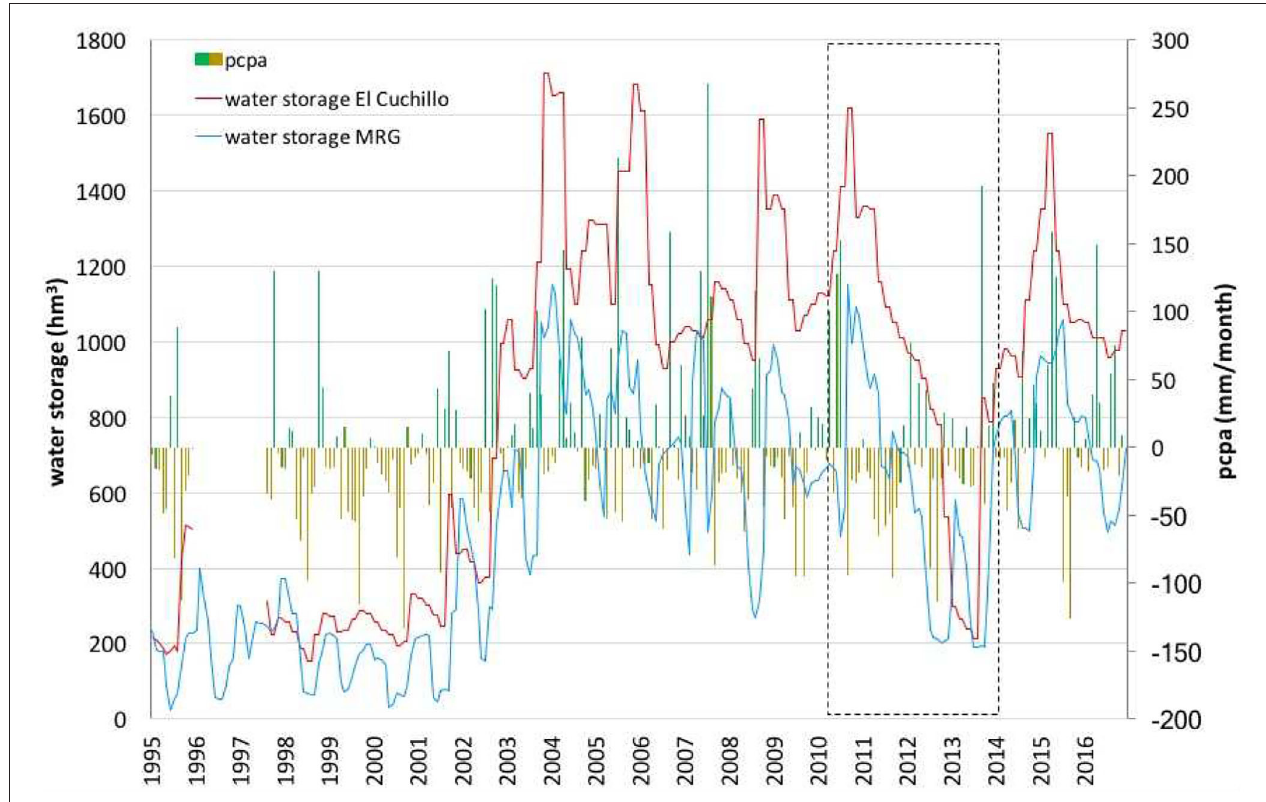
FIGURE 7 | Monthly precipitation anomalies (mm/month) at El Cuchillo dam reservoir (green- brown bars) and monthly water storage (thousands of cubic meters) at El Cuchillo and Marte R. Gomez dam reservoirs, between 1995 and 2016. The dashed line box indicates the periods of a prolonged meteorological drought between the occurrence of landfalling TCs. (Data source: BANDAS,